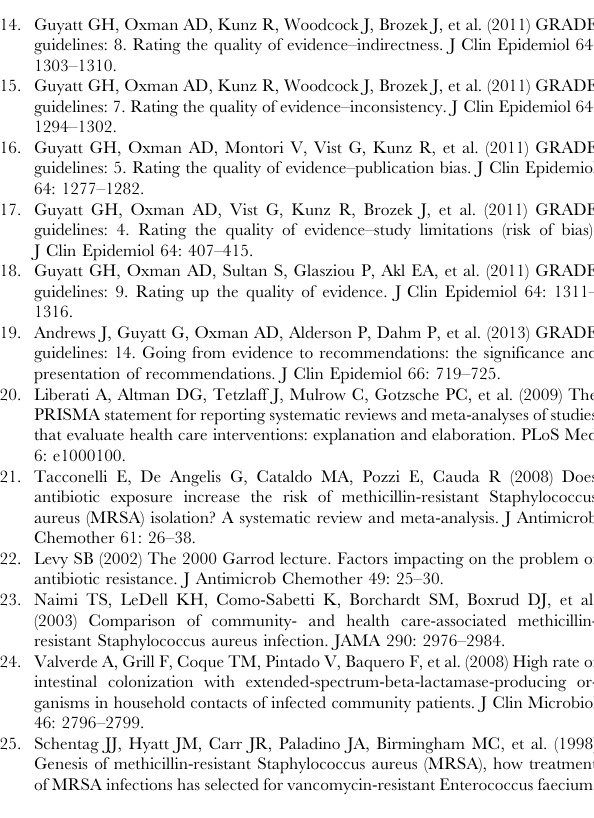
Figure S1 Absolute proportions differences and relative risks for the studies concerning the first query. (PDF) Figure S2 Absolute proportions differences and relative risks for the studies concerning the second query. (PDF) Figure S3 Absolute proportions differences and relative risks for the studies concerning the third query. (PDF) Figure S4 Absolute proportions differences and relative risks for the studies concerning the fourth query. (PDF) File S1 MEDLINE database search, flow diagram illustrating the literature selection process, and Table S1 illustrating evidence assessment for the first query. (DOCX) illustrating the literature selection process, and Table S2 illustrating evidence assessment for the second query.